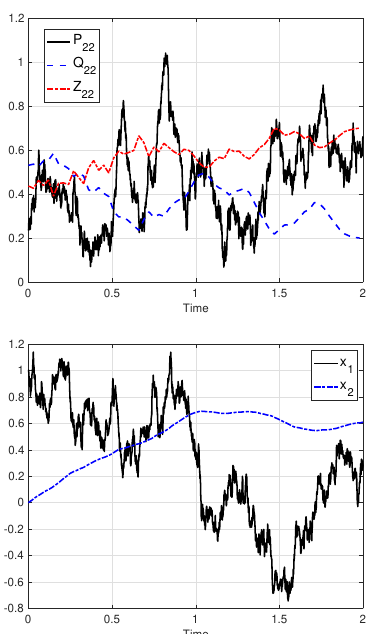
Figure 2. The simulation results of Example 3: the sample path of the ISRDE with jump diffusions ( P ) in Equation (27) ( left ); the sample path of the BSDE with jump diffusions ( p 22 , Q 22 , Z 22 in Equation (28) ( middle ); the sample path of the controlled state process in Equation (26) under the optimal control in Equation (29) ( right